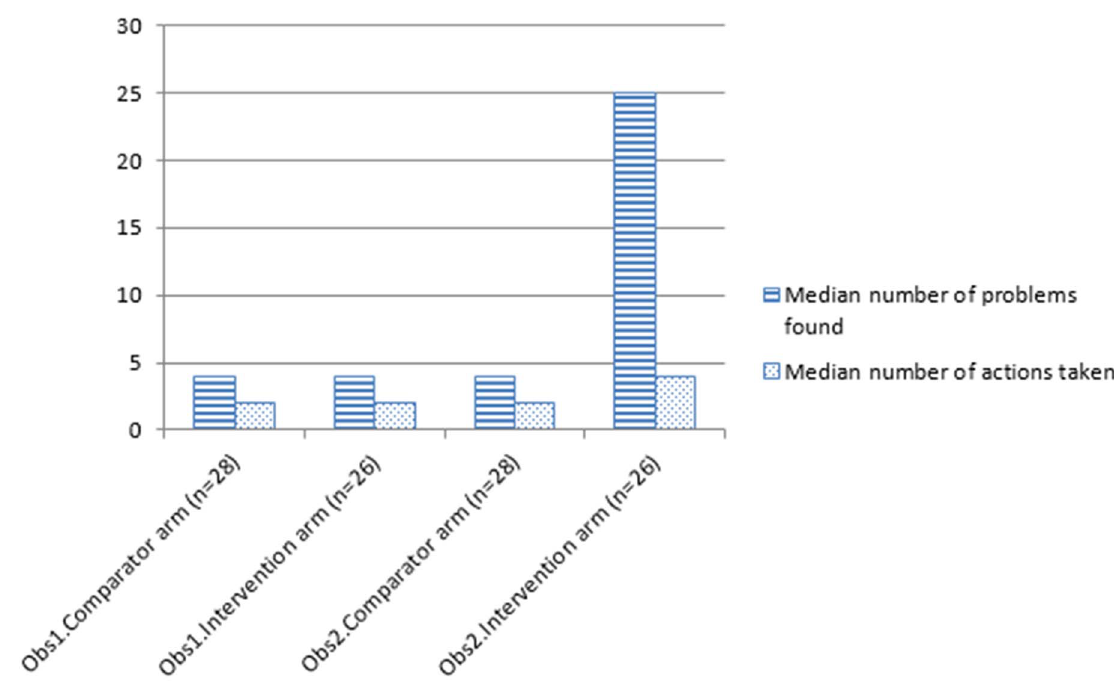
Figure 2. Bar chart of problems found and actions taken par participant at observations one and two.